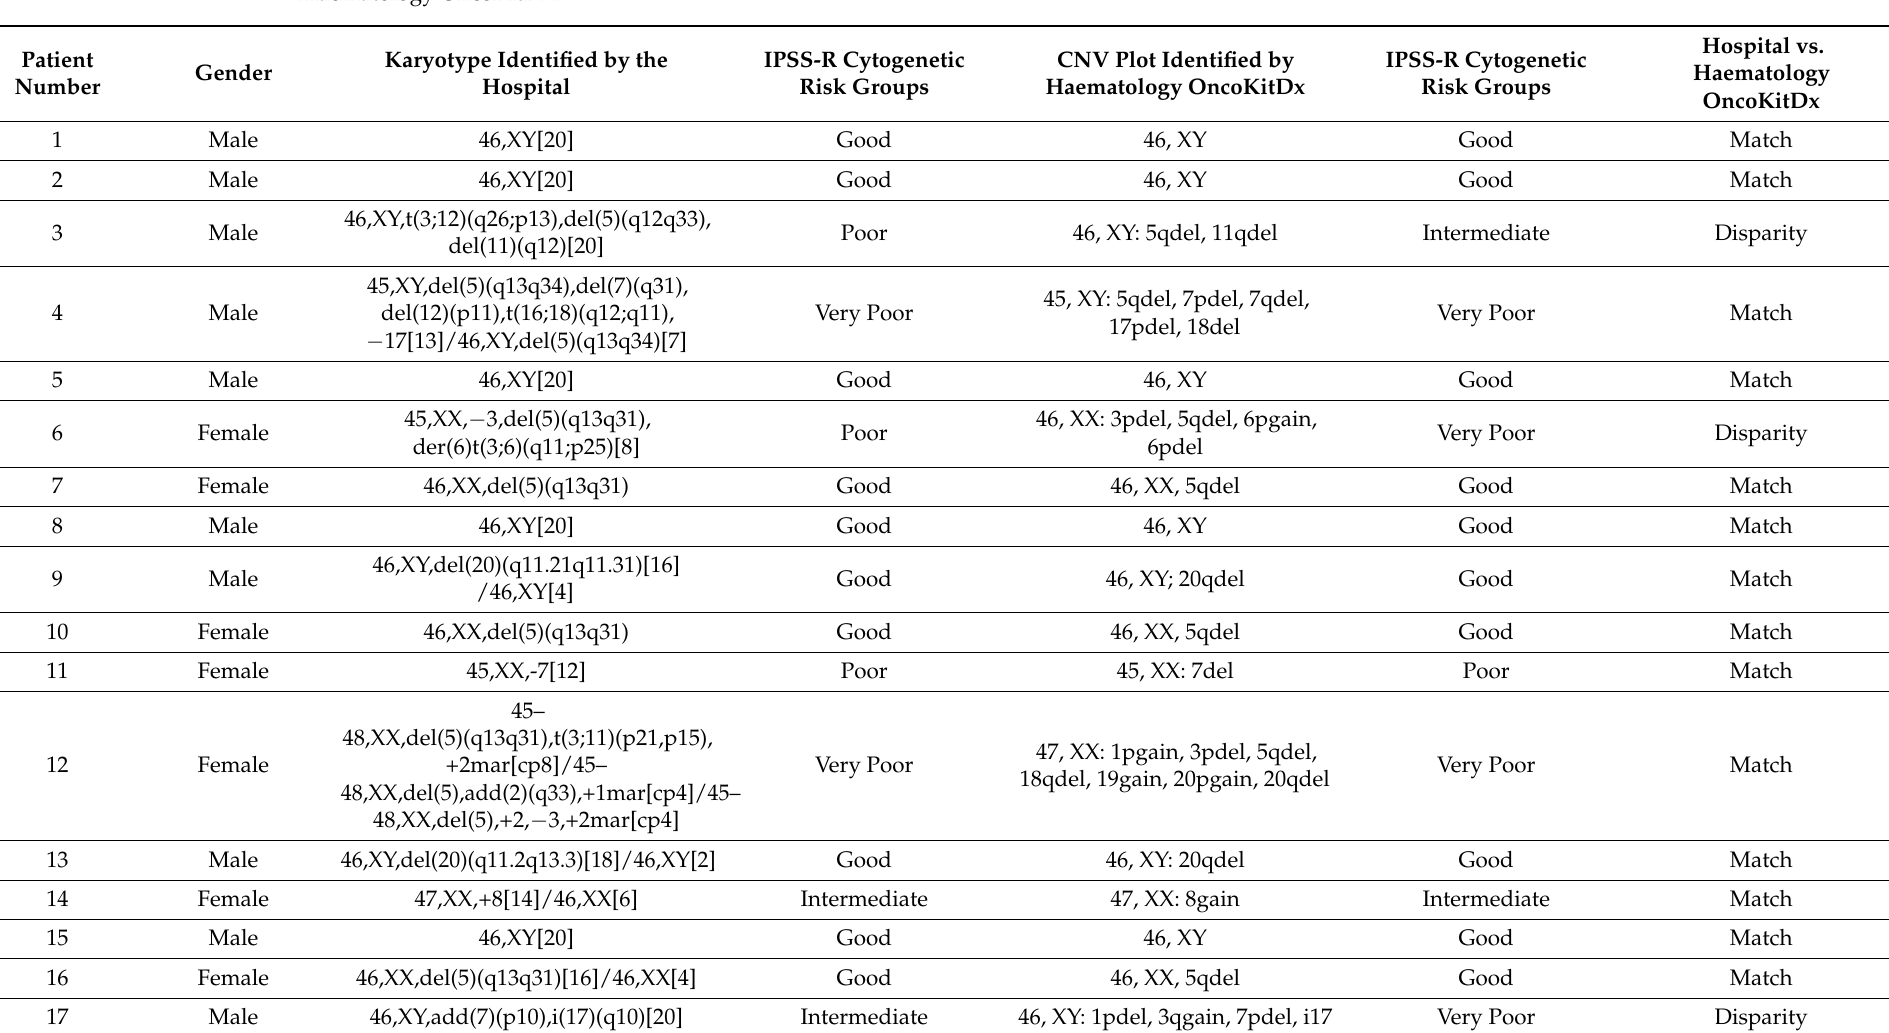
Table 2. Cytogenetic risk assigned by conventional karyotype according to the IPSS-R classification vs. that obtained from the CNV plot generated by Haematology